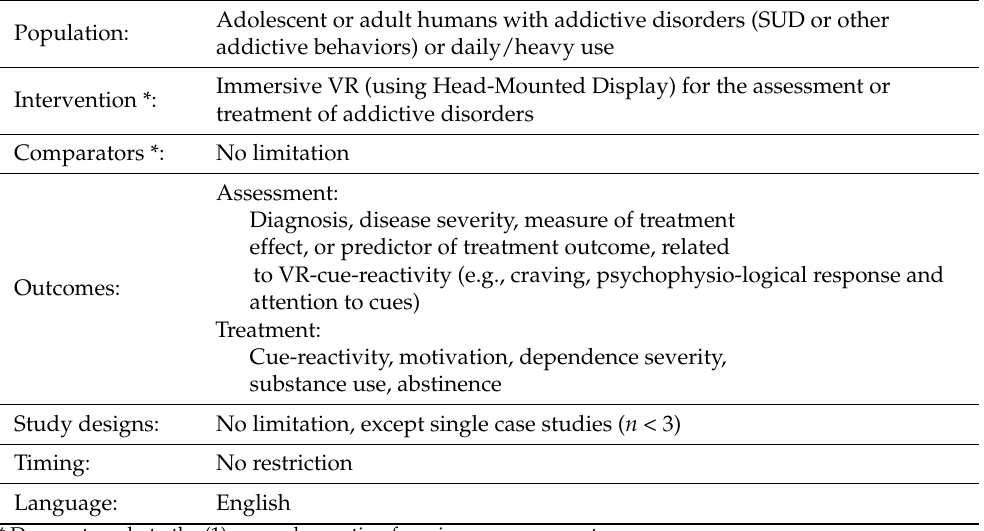
Table 1. PICOS framework to identify eligibility